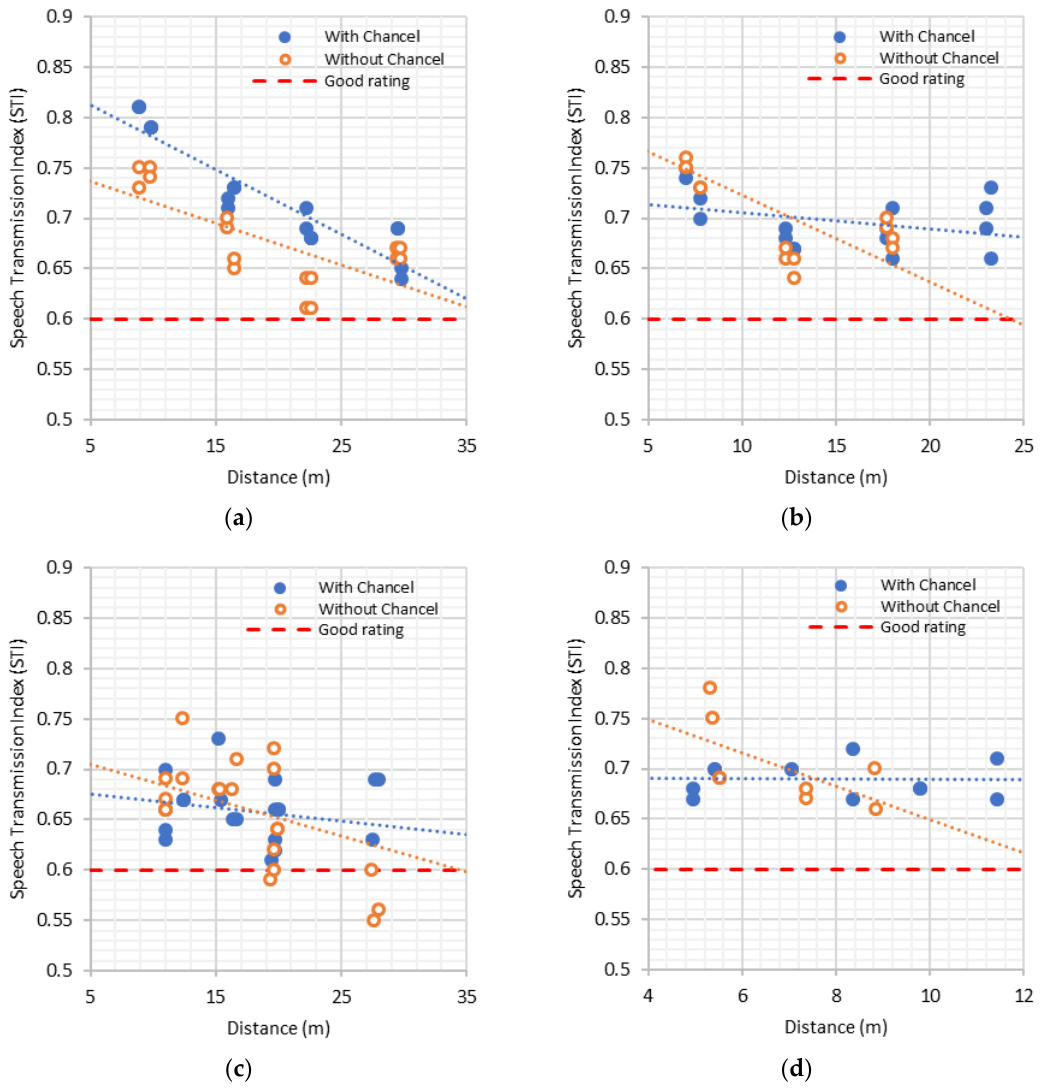
Figure 2. Comparison of the average STI between the simulations with a chancel and without a chancel: ( a ) C1; ( b ) P1; ( c ) P2; ( d ) R1. (Blue and orange dotted lines are the trendlines for both with and without chancel data, respectively).